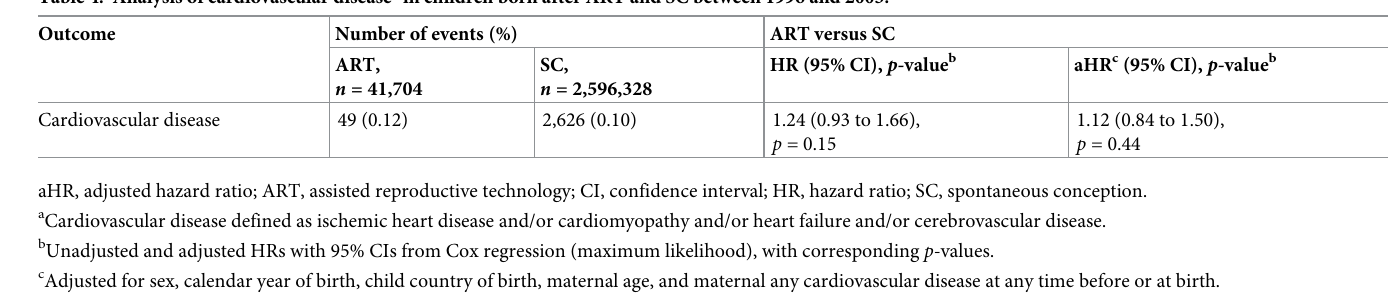
0.79 to 2.37; p = 0.26). Another sensitivity analysis was performed in which children born between 1996 and 2005 were compared for the outcome any cardiovascular disease. The mean follow-up time in this cohort was 13.7 (SD 3.1, range 0.0 to 20.0) years for children born after ART and 14.4 (SD 3.3, range 0.0 to 20.0) years for children born after SC. The analysis did not find any significant difference between children born after ART and children born after SC, neither in the unadjusted (HR 1.24; 95% CI 0.93–1.66; p = 0.15) nor in the adjusted analysis (aHR 1.12; 95% CI 0.84–1.50; p = 0.44) (Table 4). In the sensitivity analysis with a matched sample for type 2 diabetes, the overall incidence rates were consistent with the results from the Cox regression: 1.7/100,000 person-years at risk for children born after ART compared to 1.3/100,000 person-years at risk for children born after SC (unadjusted HR 1.27; 95% CI 0.78–2.07; aHR 1.25; 95% CI 0.77–2.04; p = 0.36). Subgroup analyses (FET versus fresh embryo transfer, ICSI versus IVF) In total, 27 (0.15%) children born after FET, 93 (0.12%) children born after fresh embryo transfer, 51 (0.13%) children born after ICSI, and 69 (0.12%) children born after IVF devel- oped cardiovascular disease during the study period. The corresponding values for obesity were 81 (0.50%) for children born after FET, 433 (0.68%) for children born after fresh embryo transfer (Table 5), 219 (0.54%) for children born after ICSI, and 277 (0.49%) for children born after IVF (Table 6). Neither FET nor ICSI was associated with an increased risk of any cardio- vascular disease (FET versus fresh embryo transfer: aHR 1.26; 95% CI 0.80–2.00; p = 0.32; ICSI versus IVF: aHR 1.12; 95% CI 0.76–1.64; p = 0.57) or obesity (FET versus fresh embryo trans-